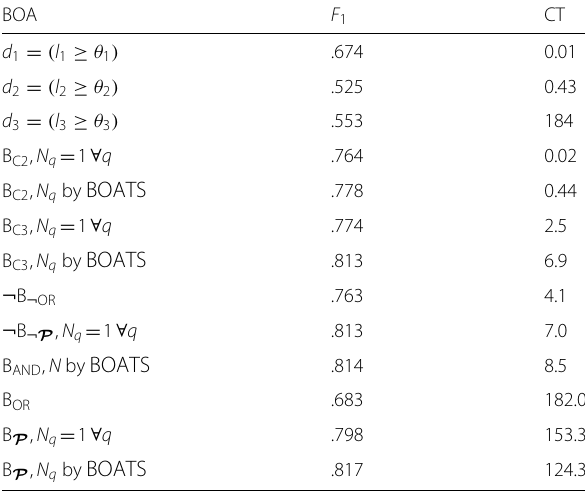
At the same time it reaches F 1 = .764, which is about 9 percent units higher than .674 of d 1 , 14 percent units higher than .525 of d 2 and 11 percent units higher than .553 of d 3 . With N of B C2 not restricted, the F 1 -score fur- ther improves to .778, but the computational benefit over always computing both l 1 and l 2 is